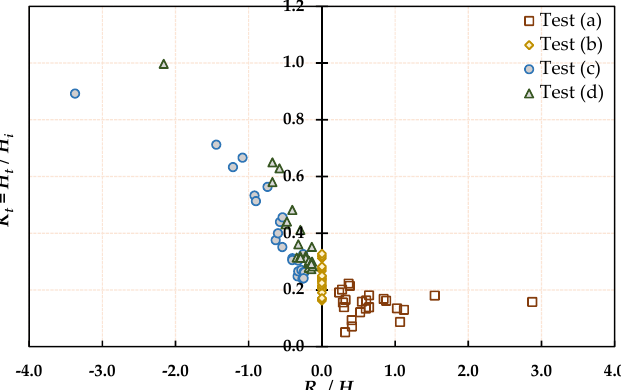
Figure 4. Effect of relative freeboard ( R c / H i ) on wave transmission ( K t ). The relation between the transmission coefficient and relative freeboard, which is nondimensionalised by 𝐷 (cid:3041)(cid:2873)(cid:2868) , is shown in Figure 5. This figure shows that the transmis- sion coefficient varies from 0.05 to 0.22 for the emerged breakwater (test (a)), which also has a small crest width. For the zero-freeboard breakwater (test (b)), 𝐾 (cid:3047) ranges from 0.16 to 0.33. On the other hand, the value for 𝐾 (cid:3047) is between 0.24 and 0.89 and 0.27 and 0.99 for submerged breakwaters, tests (c) and (d), respectively.